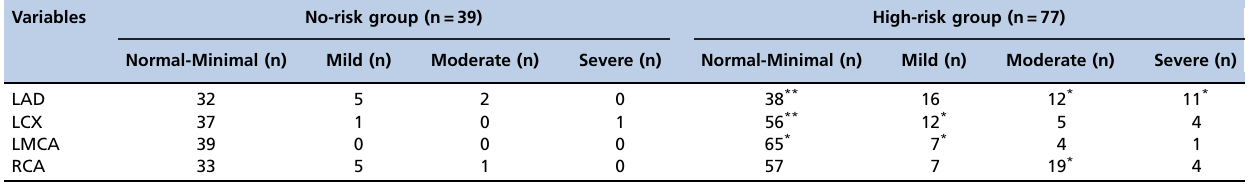
Table 3 - The degree of coronary artery stenosis between the two groups. Variables